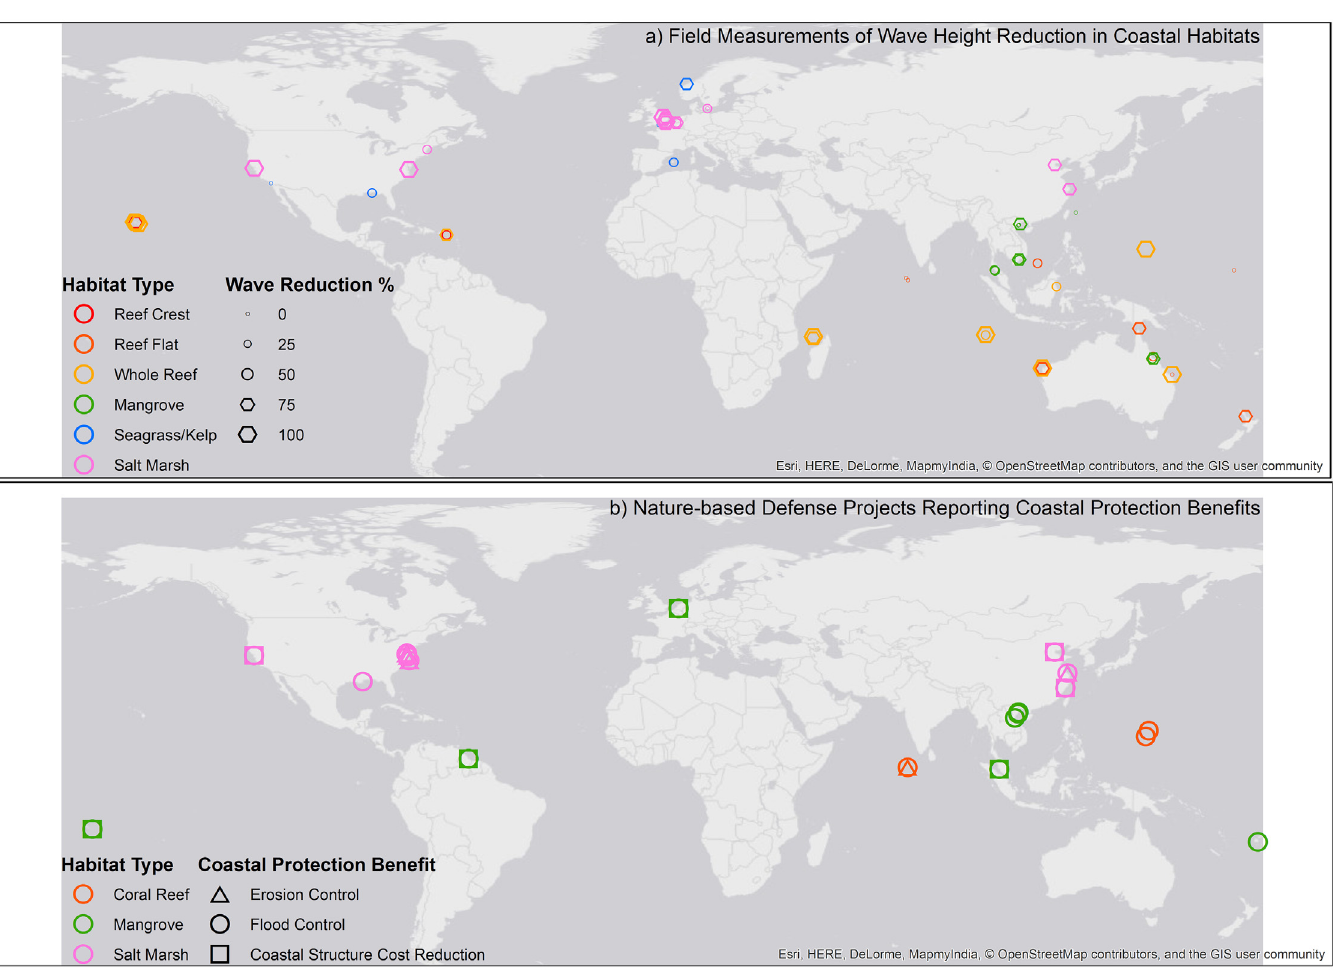
Fig 2. Global map of a) wave height reduction in natural defences (n = 69) and b) Coastal protection benefits from restoration projects (n = 52). Panel (a) maps wave height reduction measurements in coral reefs, salt marshes, mangroves, seagrass beds, kelp beds; Panel (b) maps restoration projects reporting coastal protection benefits reviewed for coral reefs, salt marshes and mangroves (the literature search did not find information on oyster reef projects that observe coastal protection benefits). Colours indicate habitat groups in both panels. Circle sizes in (a) indicate the % wave height reduction measured at each site; shapes in (b) indicate type of coastal protection benefit reported (erosion control, flood control, or protection to structures) (see Table 1). Basemap image is the intellectual property of Esri and is reprinted from Esri under a CC BY license with permission from Esri and its licensors,